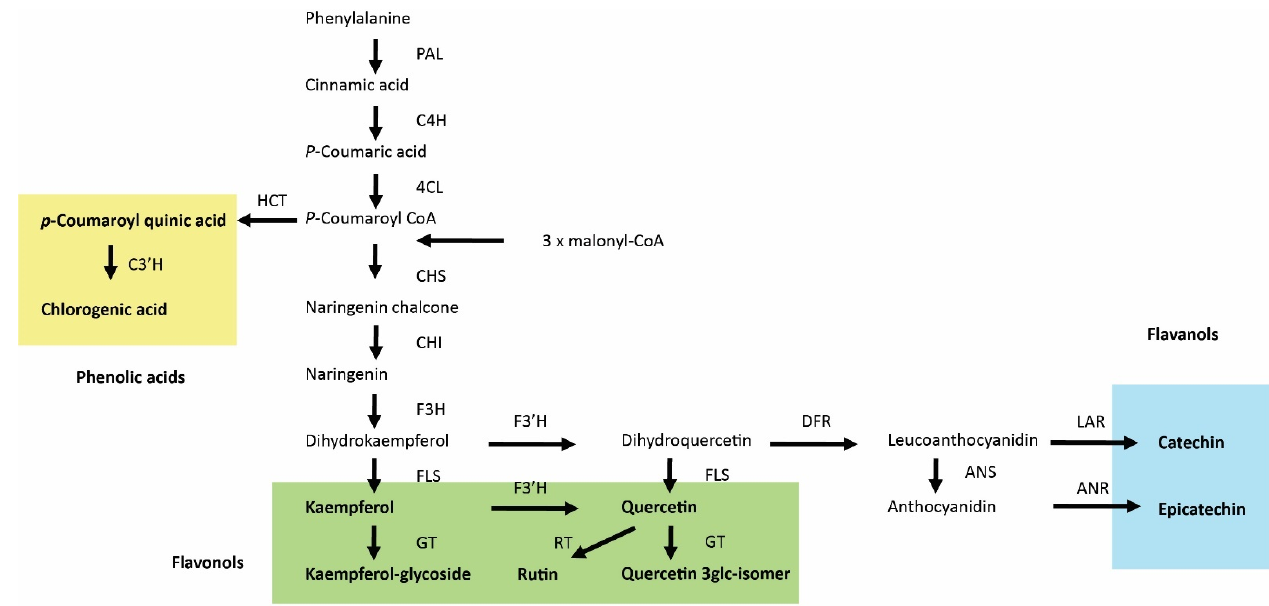
Figure 9. General phenolic acid and flavonoid biosynthesis in plants. PAL, phenylalanine ammonia lyase; C4H, cinnamic acid 4-hydroxylase; 4CL, 4-coumaric acid:CoA ligase; HCT, Hydroxycinnamoyl-CoA shikimate/quinate hydroxycinnamoyltransferase; C3 ′ H, p-coumaroyl-shikimate/quinate 3 ′ -hydroxylase; CHS, chalcone synthase; CHI, chalcone isomerase; F3H, flavanone 3-hydroxylase; F3 ′ H, flavonoid 3 ′ -hydroxylase; FLS, flavonol synthase; GT, glucosyltransferases; RT, rhamnosyltransferase; DFR, dihydroflavonol 4-reductase; ANS, anthocyanidin synthase; LAR, leuacoanthocyanidin reductase; ANR, anthocyanidin reductase. Phenolic acids, flavonols, and flavanols are labeled by yellow, green, and blue backgrounds, respectively.